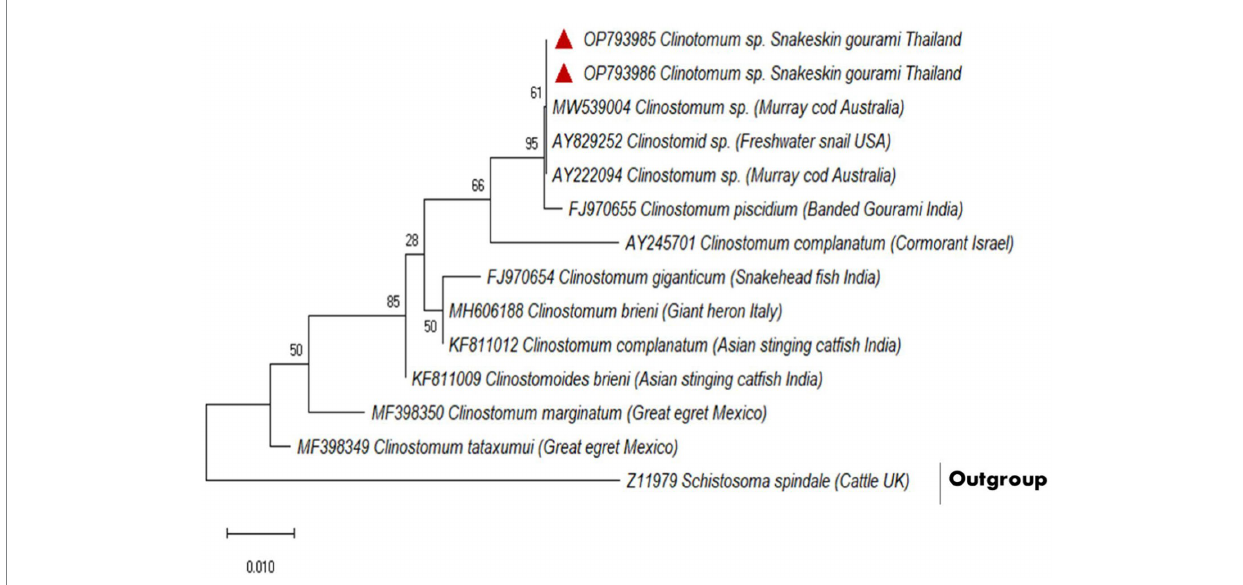
FIGURE 2 Based on a partial 18S rDNA sequence, the evolutionary relationships between clinostomids were determined using the maximum likelihood method.